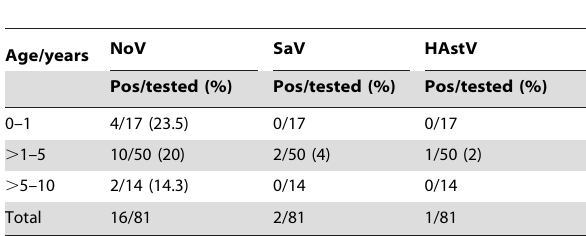
Table 2. Distribution by age group of positive samples for norovirus, sapovirus and astrovirus detected in children from the Abacatal ‘‘Quilombola’’